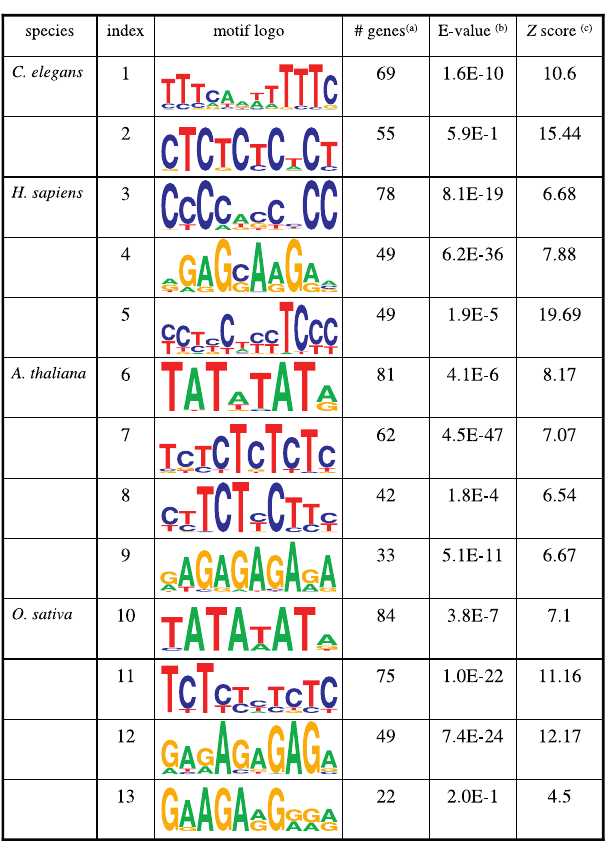
Figure 2. Significant Conserved Motifs Discovered in the Putative Promoters of the Four Species (A) The number of microRNA genes that contain the corresponding motifs in their upstream. (B) Expected frequencies of the corresponding motifs. (C) Z -scores obtained by Monte Carlo Simulations (see the section Motif Analysis).